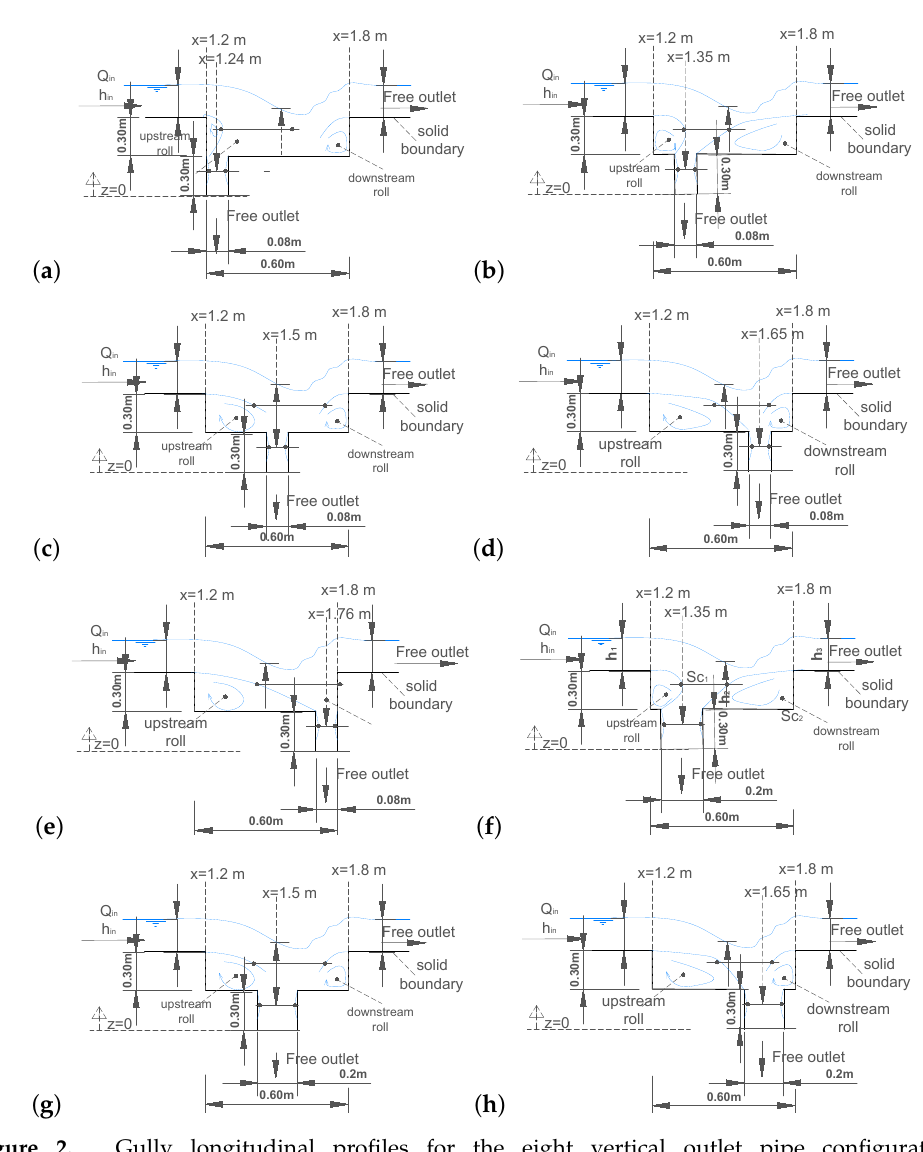
Figure 2. Gully longitudinal profiles for the eight vertical outlet pipe configurations: ( a ) Config. 1— D op = 80 mm, P op = 1.24 m; ( b ) Config. 2— D op = 80 mm, P op = 1.35 m; ( c ) Config. 3— D op = 80 mm, P op = 1.5 m; ( d ) Config. 4— D op = 80 mm, P op = 1.65 m; ( e ) Config.